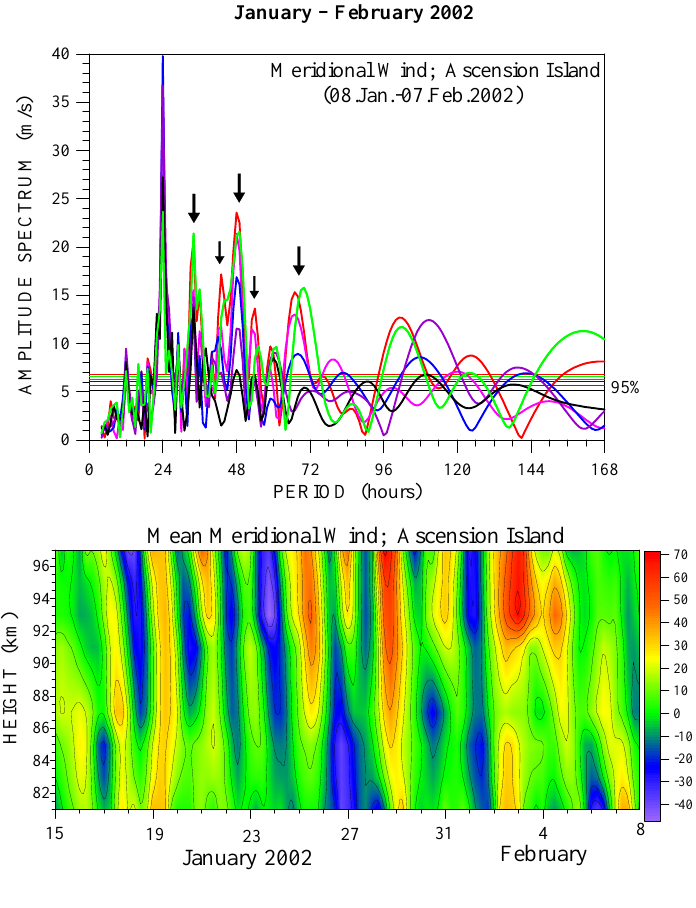
Table 1. Characteristics (period, maximum amplitude and vertical wavelength) of the quasi-2-day wave observed at Ascension